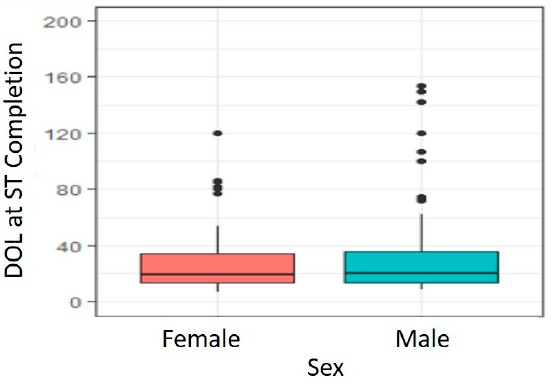
Figure 1. Effect of Birth Weight on Age at Successful Completion of Sweat Chloride Testing.